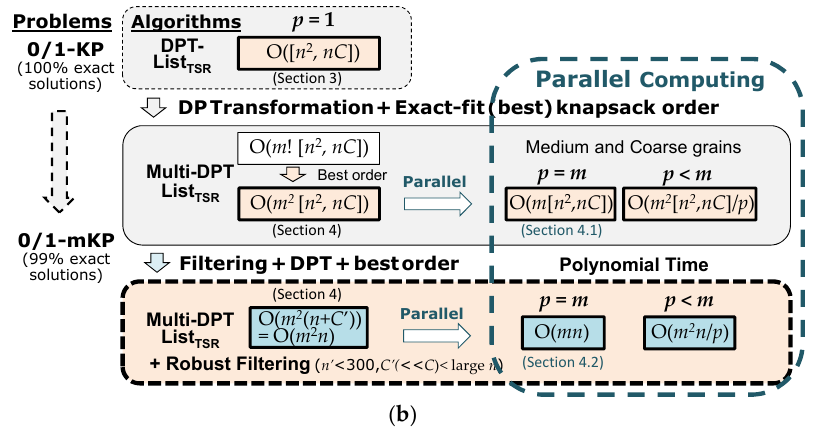
Figure 8. ( a ) Our novel research track for solving 0/1-mKP in polynomial time with 99% optimal solutions and ( b ) our multi-DPT-List TSR algorithm and efficient parallel models.